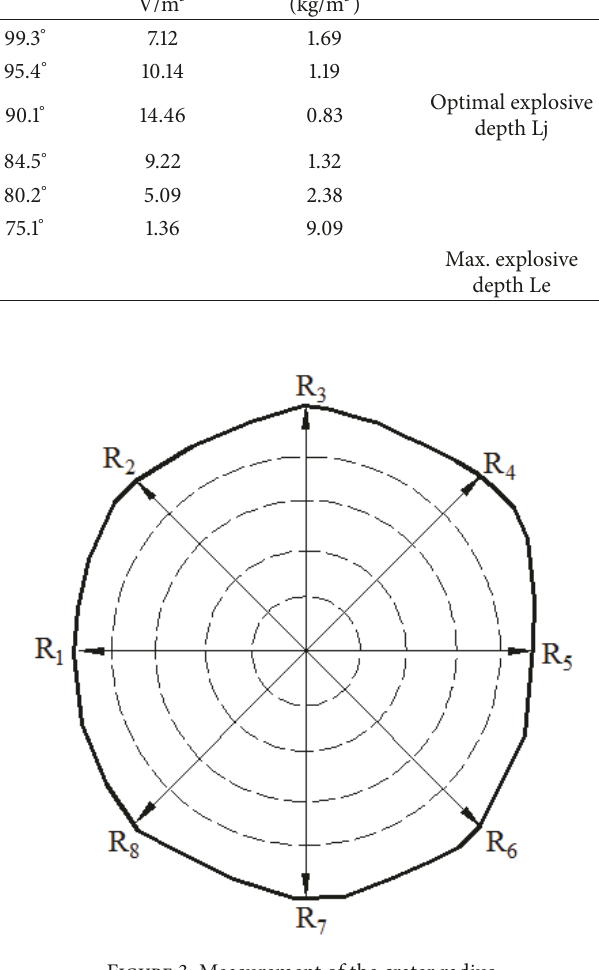
Figure 3: Measurement of the crater radius.